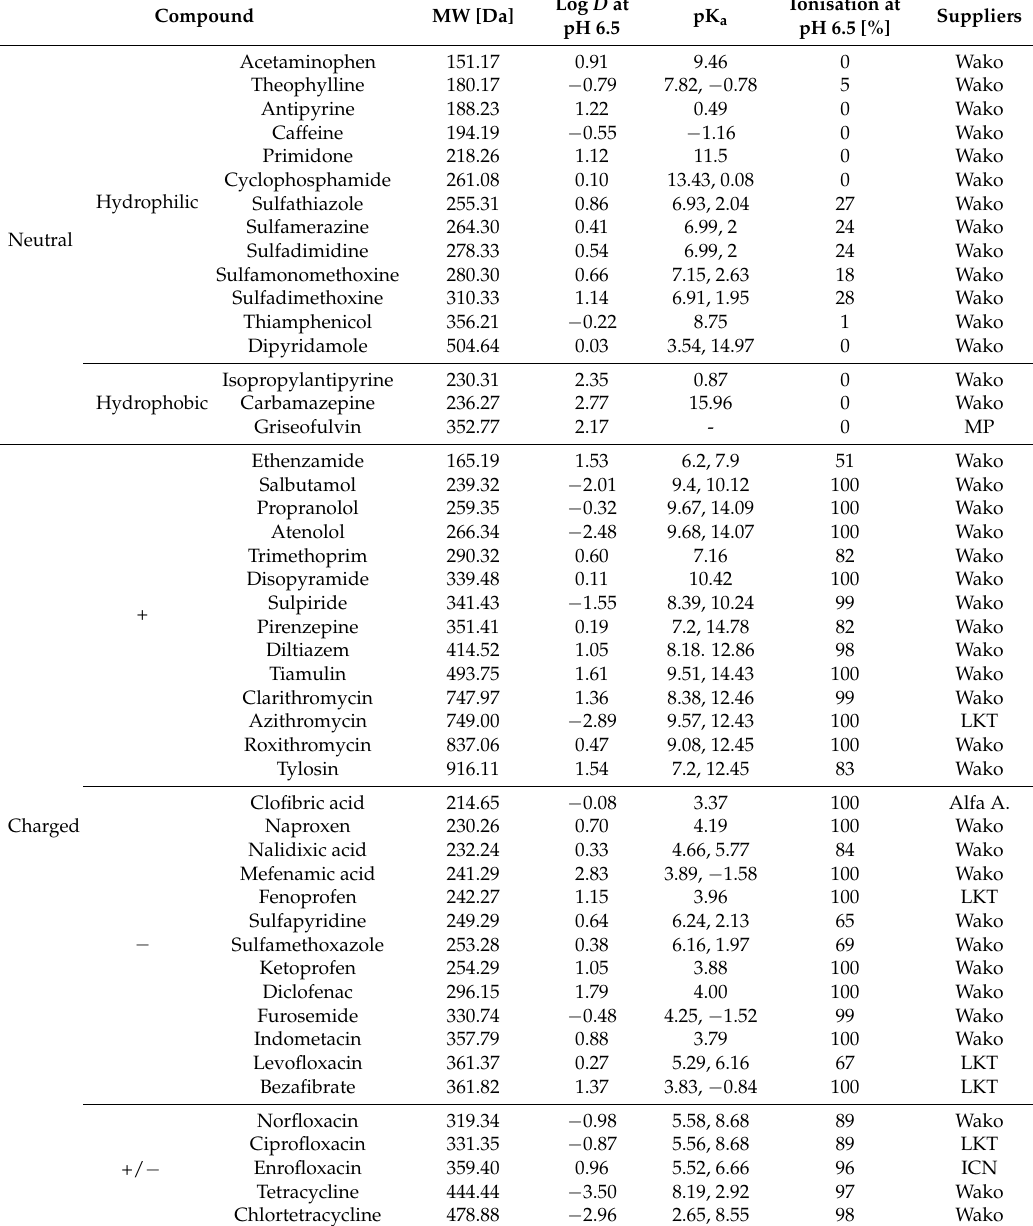
Table 1. Physicochemical characteristics of the selected pharmaceuticals and personal care products (PPCPs) (data from ChemAxon (https://www.chemaxon.com/)). Log D at Compound MW [Da] pH 6.5